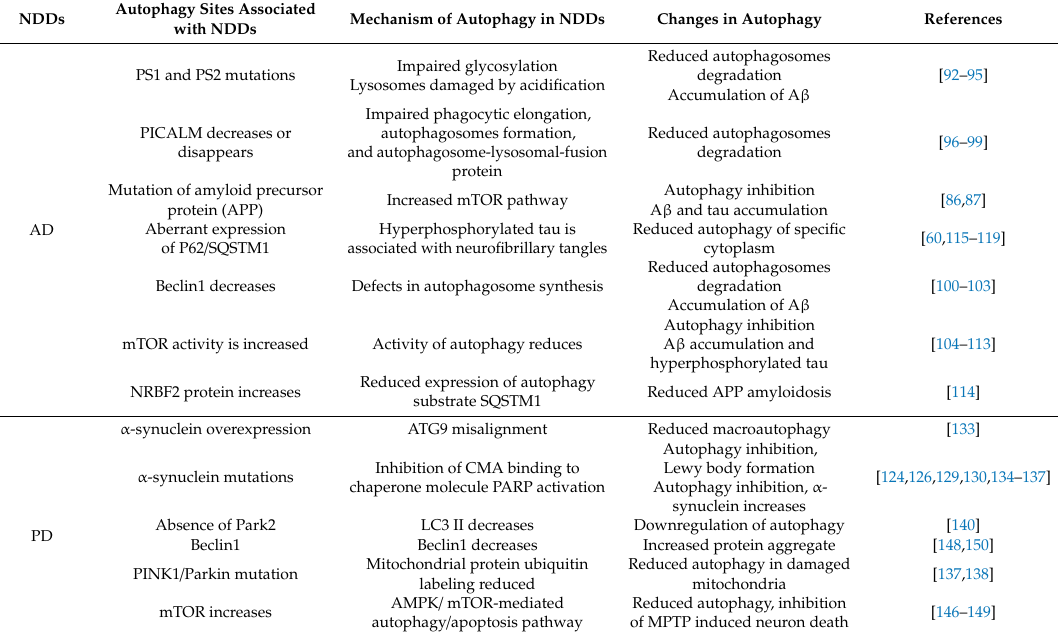
Table 2. Autophagy and various neurodegenerative diseases